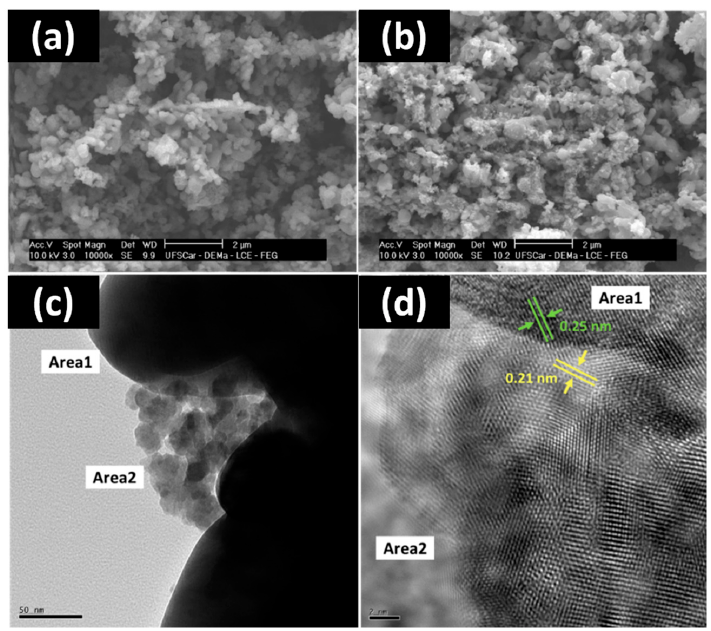
Figure 2. SEM images of Nb 2 O 5 ( a ) and Nb 2 O 5 -CdS ( b ). TEM ( c ) and HR-TEM ( d ) images of Nb 2 O 5 -CdS (Area1 – Area2) and the calculated lattice spacings (0.25 and 0.21 nm).